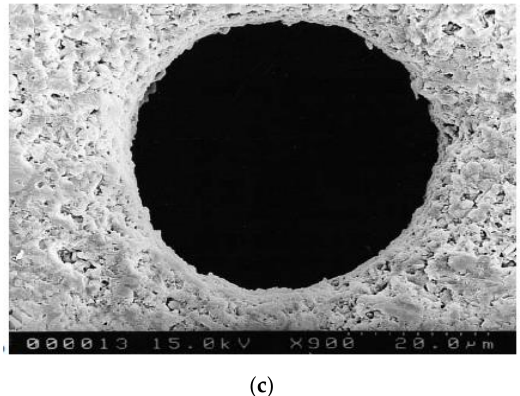
Figure 11. ( a ) Electrical resistivity of TiN/Si 3 N 4 composites as function of TiN content ( b ) 40 vol. % small TiN/Si 3 N 4 ; large white areas represent TiN while gray regions indicate Si 3 N 4 ( c ) 700 µm depth and 70 µm dia. hole machined by Micro EDM. (Reproduced with permission from [97]).